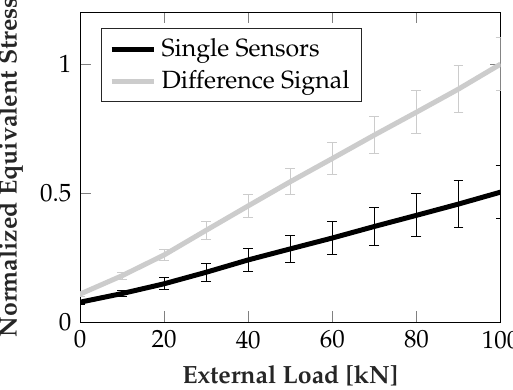
Figure 8. Comparison of sensor signal magnitudes for single sensors and difference signal.